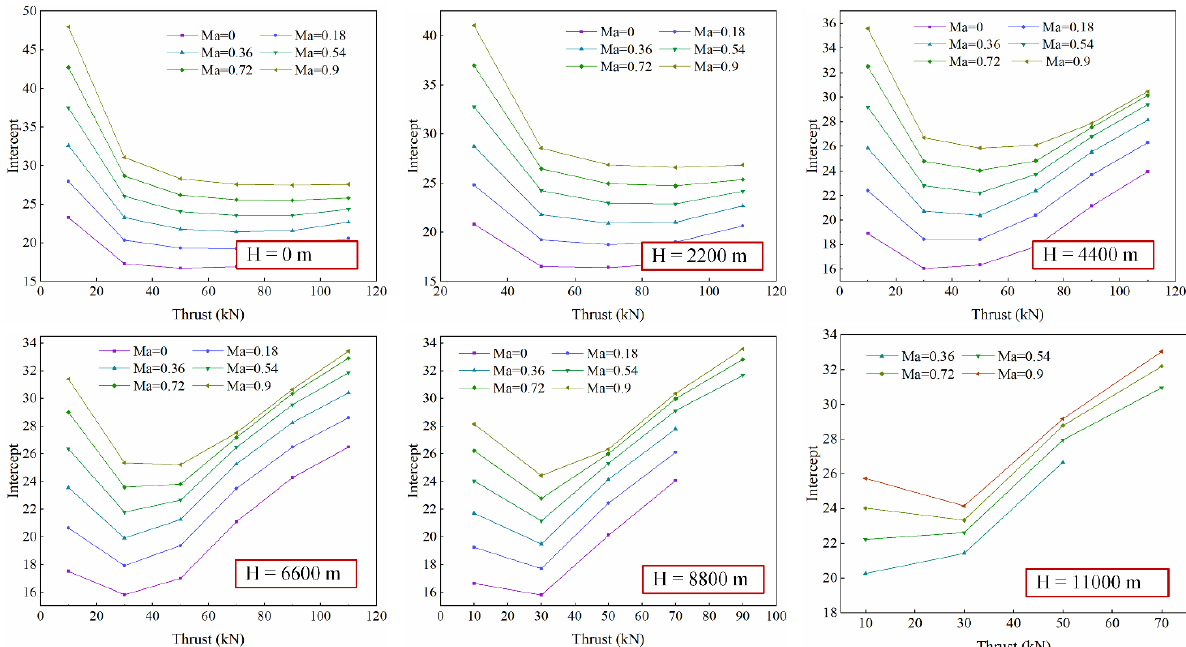
Figure 6. Influence of electric power extraction on the slope of the fitted line.